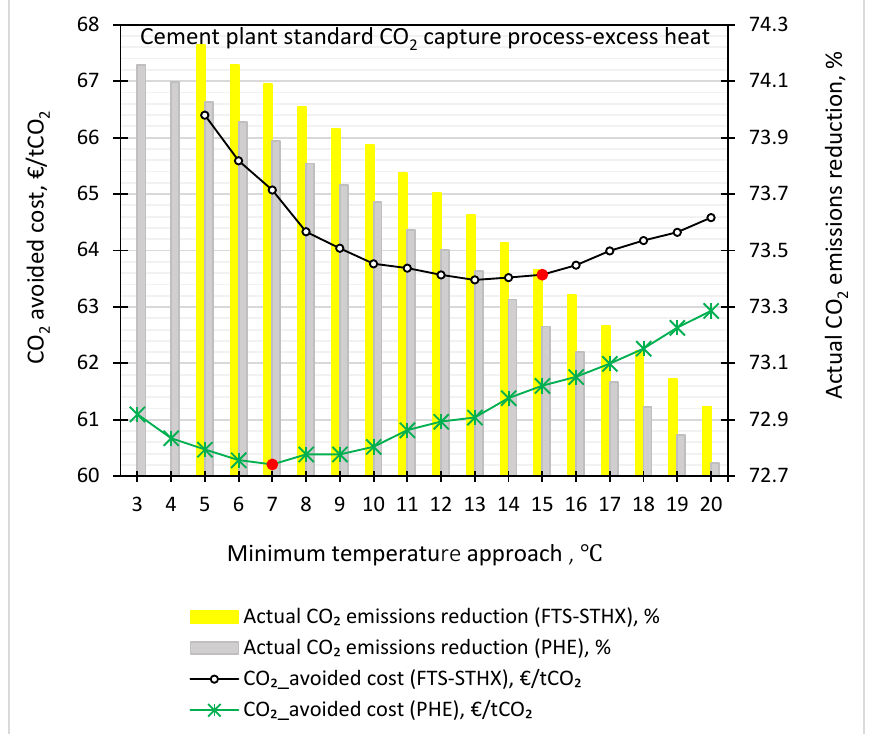
Figure 16. Energy and heat exchanger costs trade-off analysis at different ∆ T min for different heat exchanger types in a standard CO 2 capture from cement flue gas (red dot is the ∆ T min where optimum CO 2 capture cost is achieved, which can be different from the CO 2 avoided cost optimum ∆ T min ).